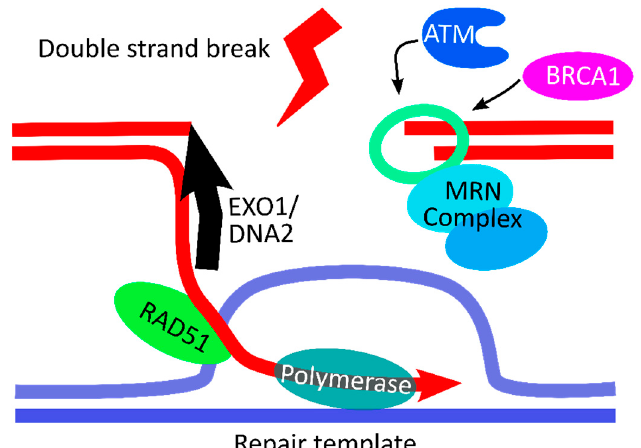
Figure 1. Illustration of key steps of the homology-directed recombination mechanism. Homology- directed repair is initiated as ATM binds to the double-strand break (DSB) and attracts BRCA1 to the DSB, along with the MRN (MRE11, RAD50, NBS1) Complex. The protein complex, along with EXO1 and DNA2, generates 3 ′ -single-stranded-DNA ends on each side of the DSB. The recombinase RAD51 works in concert with other proteins to search for homologous DNA, which is then invaded by the free 3 ′ single-stranded DNA ends. Once found, the repair template is unwound, and a DNA polymerase synthesizes a new DNA strand. Finally, double-strand-break repair uses the 3 ′ -overhangs to create a double Holliday junction linking the two homologous regions, normally resulting in a crossover product [11–14]. Figure created using Inkscape (https://inkscape.org (accessed on 19 May 2022), Brooklyn, NY, USA).